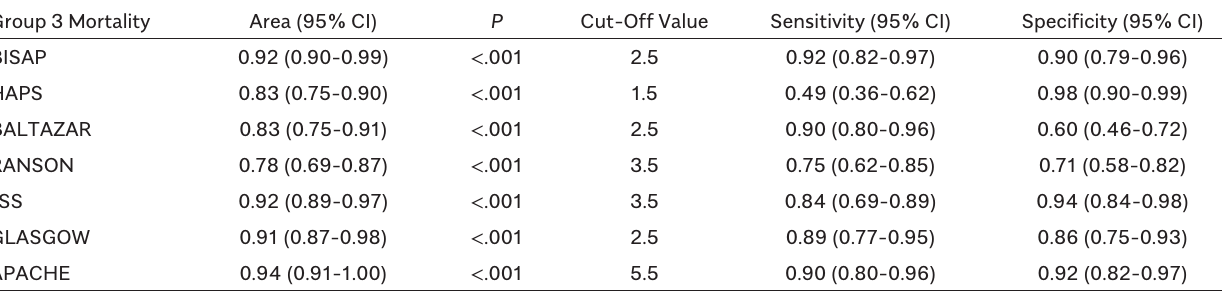
Table 6. Comparison of BISAP, HAPS, RANSON, JSS GLASGOW, and APACHE Scorings in Determining Mortality in Group 3 Patients Group 3